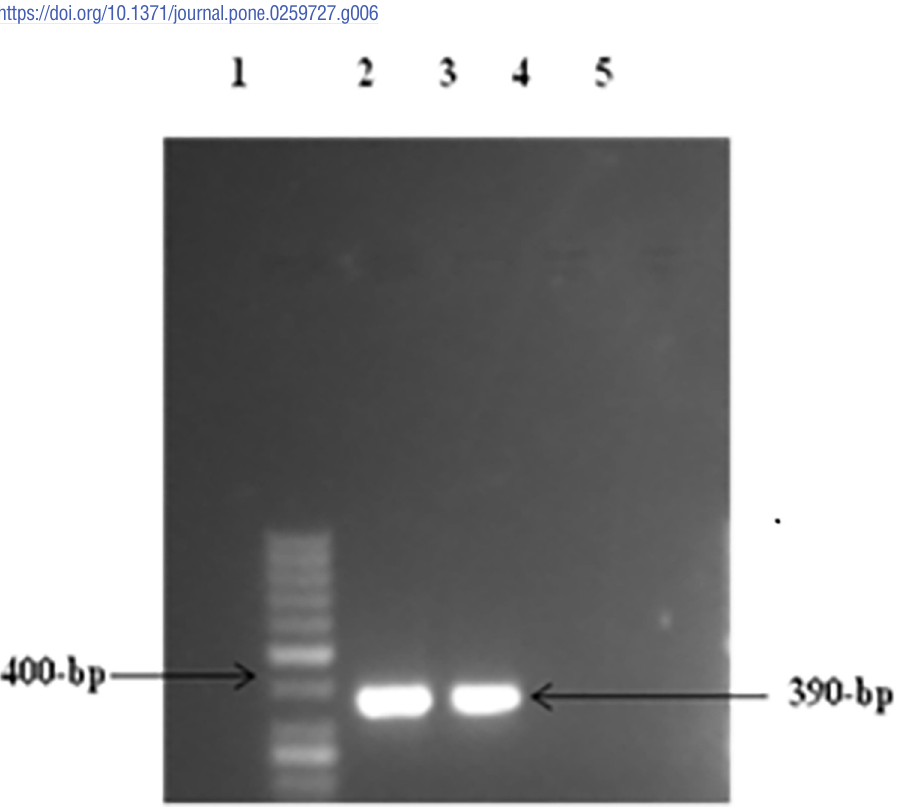
Fig 7. PCR of cell line 293T/NV. Lane 1 showed: 50-bp DNA size marker, Lanes 2,3.4 and 5 showing amplified product for NV (180-bp) (T7and BGH). https://doi.org/10.1371/journal.pone.0259727.g007 PLOS ONE | https://doi.org/10.1371/journal.pone.0259727 May 20,